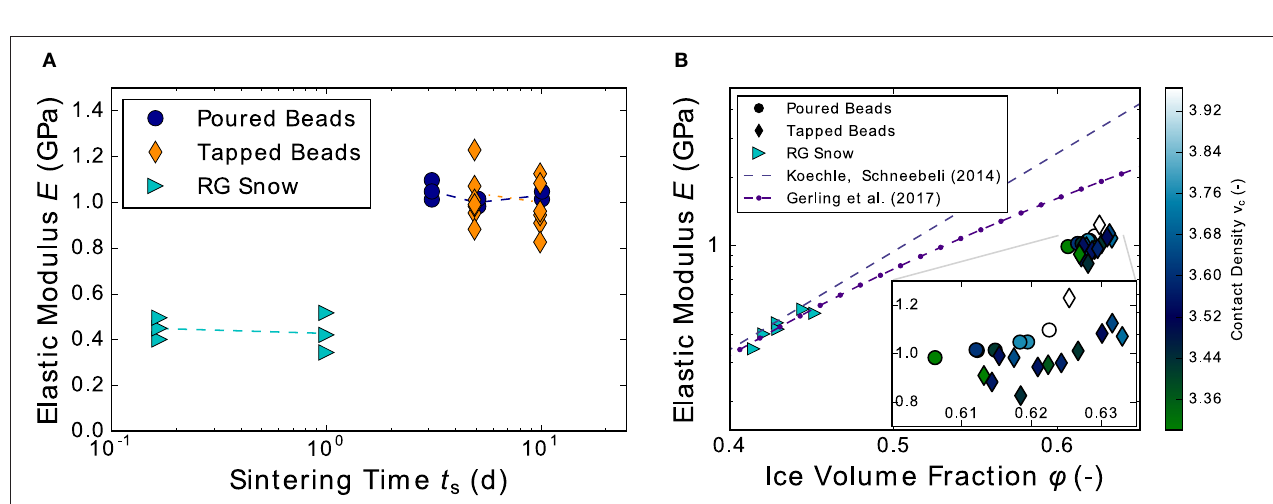
FIGURE 7 | Elastic moduli computed on the CT images: (A) against the logarithmic sintering time, the lines indicate the averages; (B) against the ice volume fraction, with the color-coded contact density for the ice beads. The inset shows a magnification of the ice bead